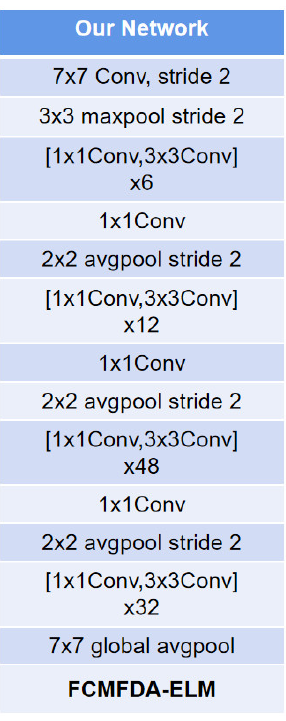
Figure 5. Structure diagram of underwater image classification network based on convolution neural network and FCMFDA-ELM.